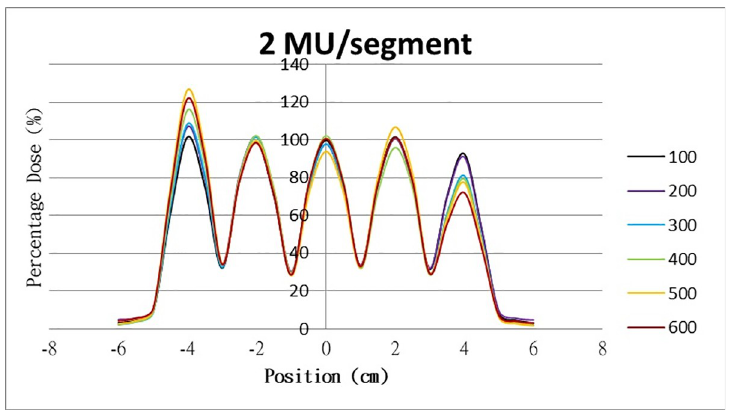
https://doi.org/10.1371/journal.pone.0250243.g007